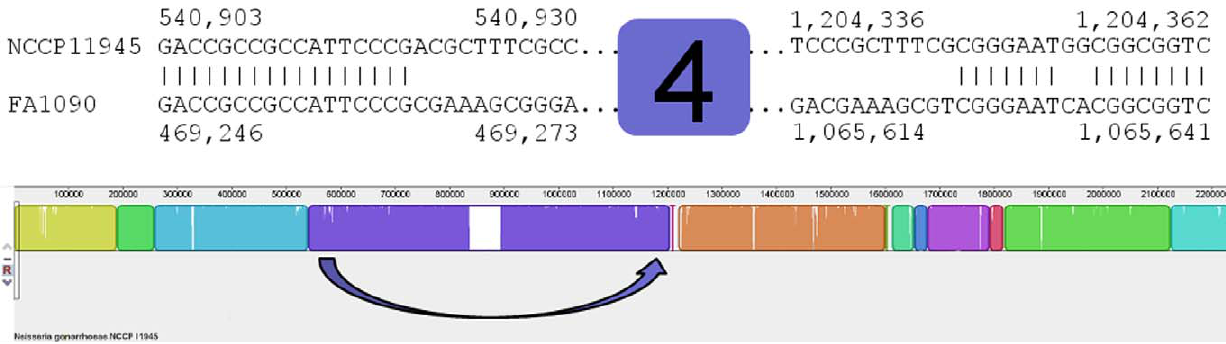
Figure 4. Model for the rearrangements of blocks 5, 7, 8, and 9. All genome sequences investigated have NGO F 3 disrupted by the insertion of NGO F 9, which appears to have been mediated by ISNgo2 elements (Tables S1 and S13). This is schematically illustrated here ( F 9), with base positions of NGO F 9 indicated as in Table S13 for both strains FA1090 (top) and NCCP11945 (bottom). In strains NCCP11945 and TCDC-NG08107, this region has had three further insertions (blue arrow): insertion of block 9 (Figure 1), containing NGO F 6 and a rRNA locus; insertion of block 8 (Figure 1), containing NGO F 8 and a section of genomic DNA; and insertion of block 7 (Figure 1). The relative location of blocks 7, 8, and 9 are schematically illustrated here with base positions from strain NCCP11945. Each rearrangement appears to have occurred separately, mediated by ISNgo2 elements (Tables S1, S10, and S12) and to have displaced block 5 (pink arrow). Note the alignment of homologous sequence flanking the locations of block 5 and blocks 7, 8, and 9, which has been zoomed to the single base level. In addition to the movements of these blocks of sequence, deletion events are also noted within NGO F 3 (Table S6).